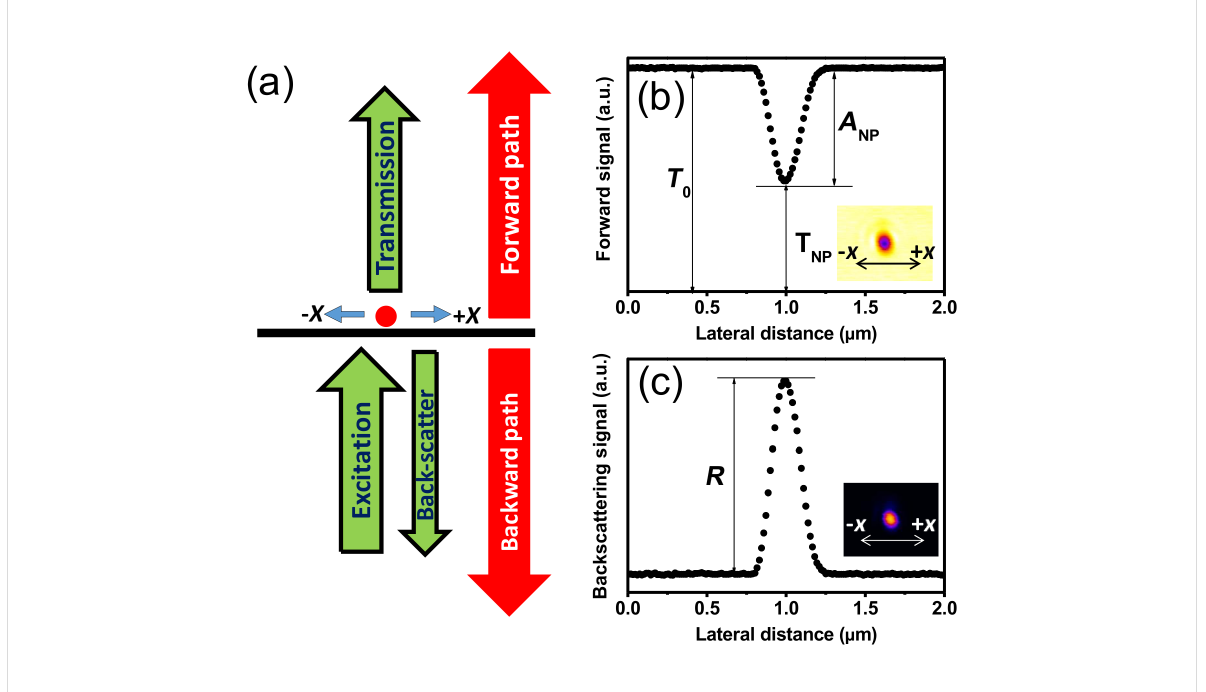
Figure 1: (a) Schematic principle of the x -scan method, the excitation focus is scanned in x -direction. The back-scattering and transmission of a single nanostructure are separately recorded in backward and forward direction. (b, c) Representative profiles corresponding to the two detection paths. (b) The dip value of the transmission profile gives the attenuation A NP of the same single plasmonic nanostructure. T 0 and T NP denote the initial laser intensity (no interaction with the nanostructures) and the transmission measured through the gold nanostructure, respectively. The peak value of (c) gives the backscattering intensity R .